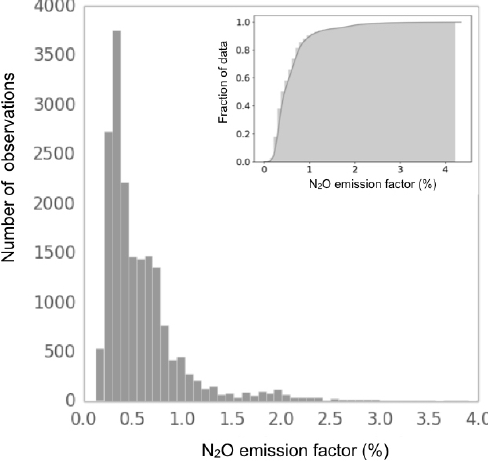
Figure 5. The distribution and cumulative distribution (small graph)